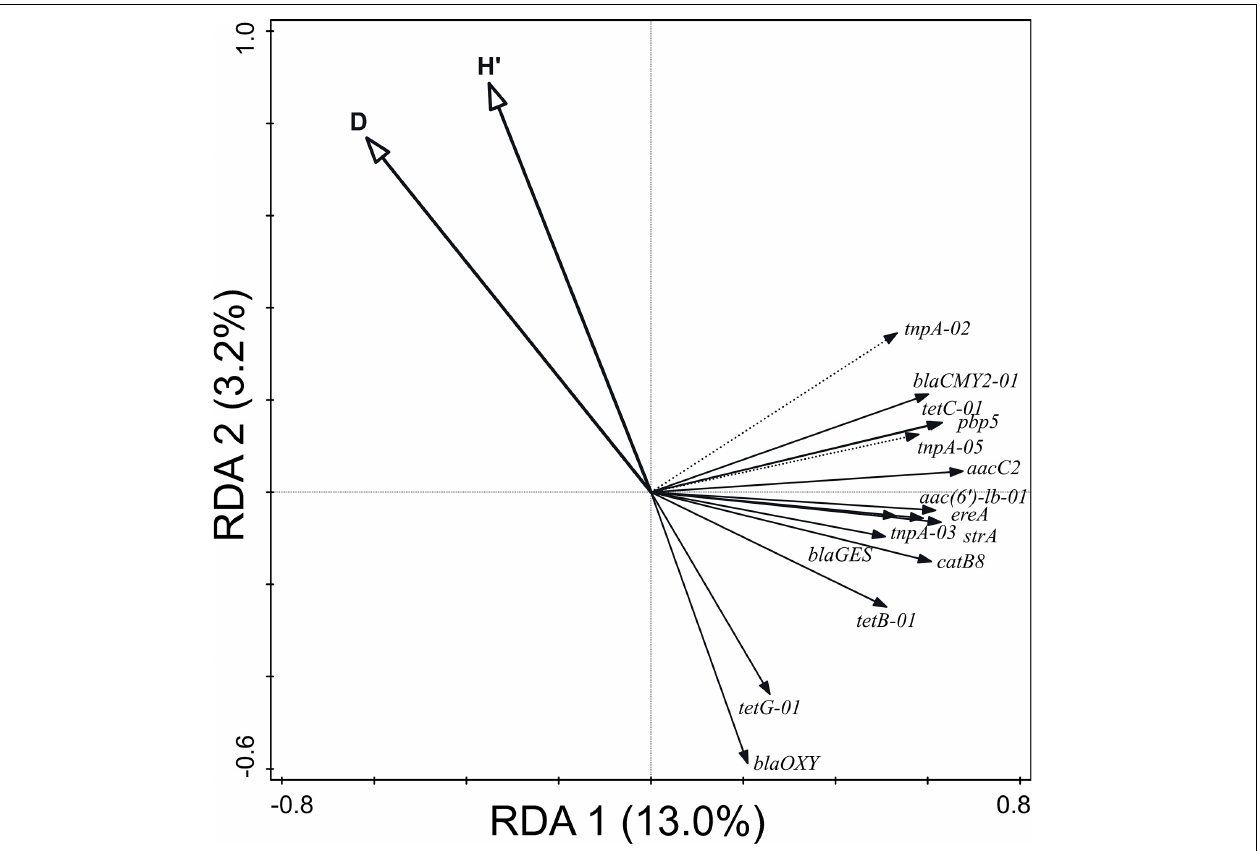
FIGURE 6 | Biplot of the RDA performed with α -diversity indices (explaining 18.9% of the variation in the abundance of ARGs and MGE-genes) as explanatory variables, the relative abundance of ARGs and MGE-genes as response variables, and field and current crop as covariates. Only statistically significant explanatory variables and response variables with the best fit are